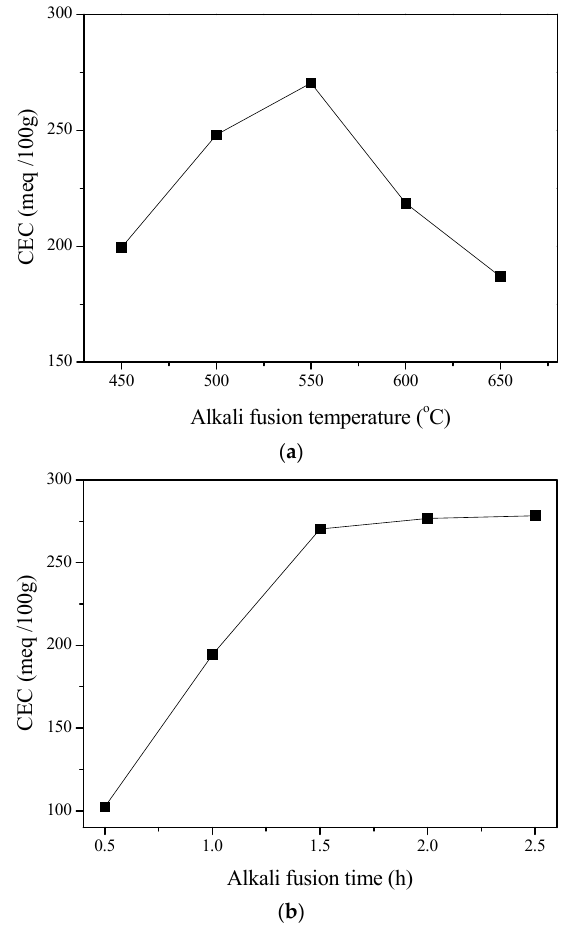
Figure 3. Effect of alkali fusion conditions on the CEC of synthesized zeolite (NaOH/coal fly ash ratio 1.2 g/g, liquid/solid ratio 5 mL/g, 15 h hydrothermal treatments under 90 °C). ( a ) Alkali fusion temperature; ( b ) Alkali fusion time.